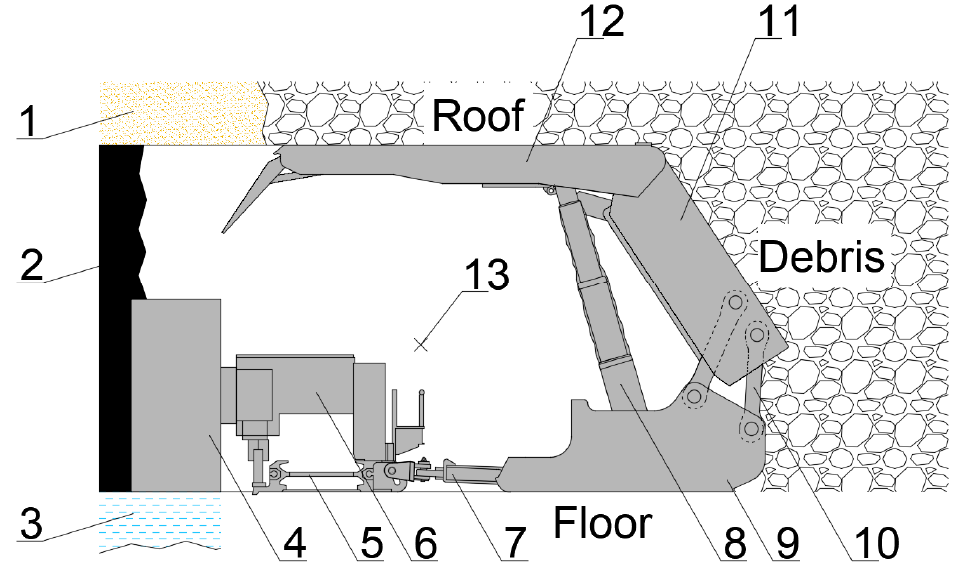
Figure 1. Arrangement of machines and equipment in a longwall complex at the measurement site, where: 1-sandstone layer, 2-coal, 3-shale layer, 4-cutting unit, 5-longwall scraper conveyor, 6-shearer, 7-sliding system, 8-hydraulic leg, 9-floor base, 10-lemniscate system, 11-shear support, 12-powered roof support, 13- place of measurement.